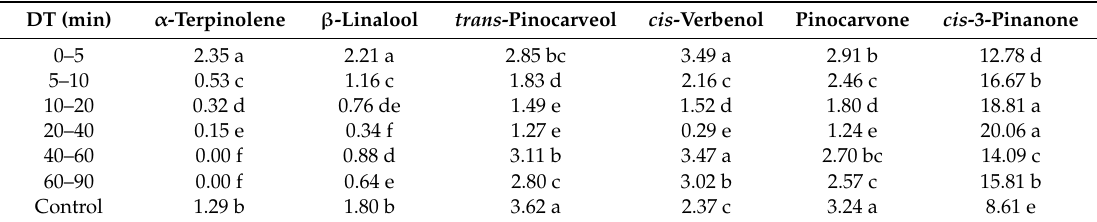
Table 8. Mean concentrations (%) of Hyssopus o ffi cinalis subsp. aristatus EO ( α -terpinolene, β -linalool, trans -pinocarveol, cis -verbenol, pinocarvone, and cis -3-pinanone) obtained from the seven distillation times (DT). Control = nonstop 0–90 min.